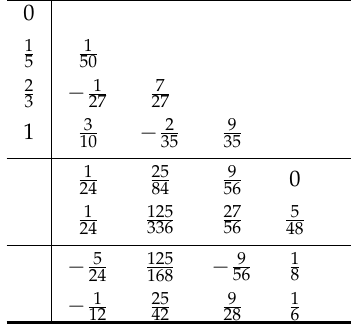
Table 1. RKN5(3) method in